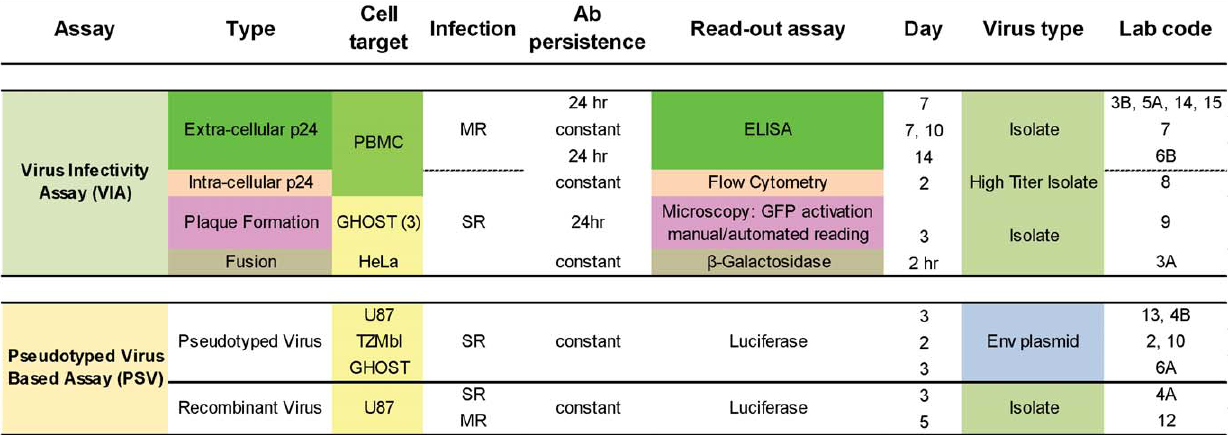
Figure 1. Neutralization assays and their characteristics. Cell target: PBMC, peripheral blood mononuclear cells; the cell lines GHOST, U87 and HeLa are stably transfected with CD4 and CCR5 or CXCR4. MR, multiple round infection; SR, single round infection. The fusion assay is limited to cell surface-viral envelope interaction. Ab persistence: time of incubation of the inhibitory reagent with virus and cells before washout. Day: time of read- out, numbers indicate days; hr, hours. Env plasmid, Env expression plasmids obtained through NIBSC.